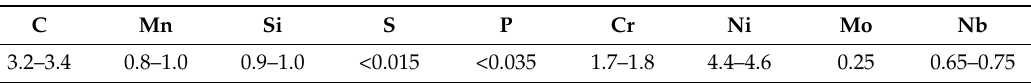
Table 1. Chemical composition range of the working layer, expressed in weight percent